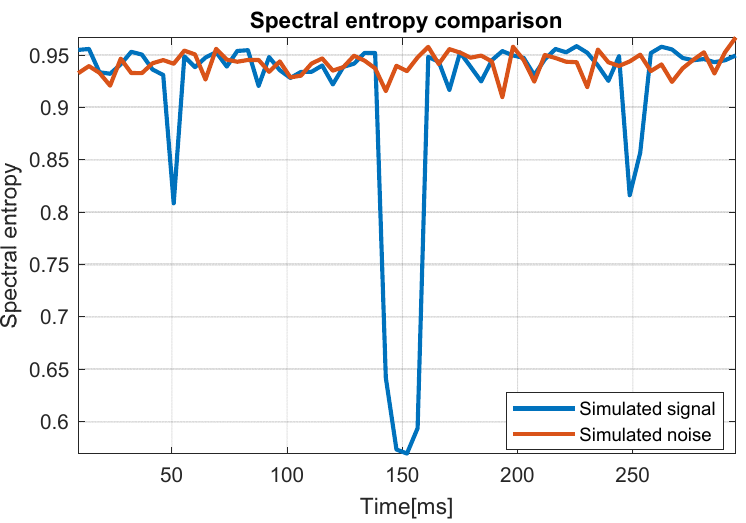
Figure 3. Spectral entropy of the two simulated signals.